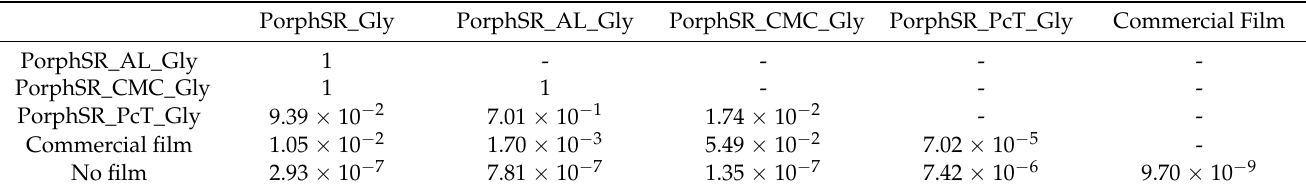
Table A1. Bonferroni pairwise comparison p -values for the different desiccant mass gains. PorphSR_Gly PorphSR_AL_Gly PorphSR_CMC_Gly PorphSR_PcT_Gly Commercial Film PorphSR_AL_Gly 1